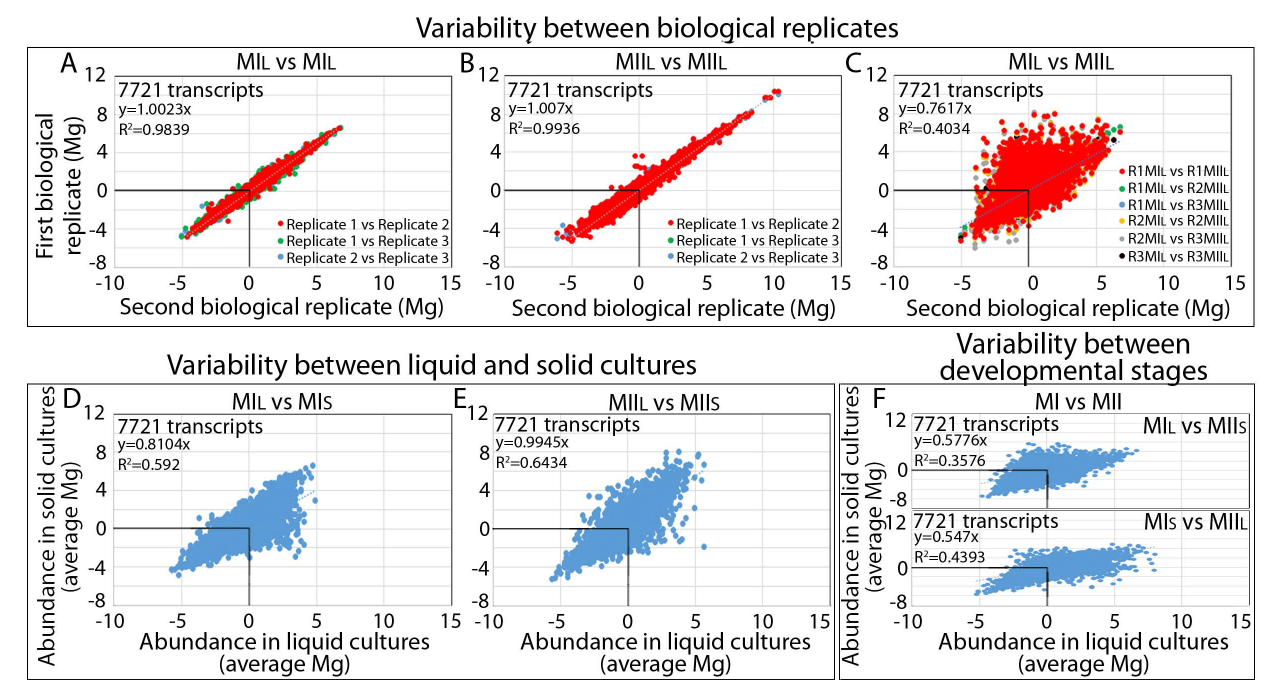
Figure 2. Quantitative transcriptomic data analysis . Correlation of transcription abundance values (log2 ratio against chromosomal DNA). Upper panels - biological replicates: (A) MIL vs. MIL, (B) MIIL vs. MIIL, (C) MIL vs. MIIL (three biological replicates compared in pairs). Lower panels - developmental stages (average abundance values from three biological replicates: (D) MIL vs. MIS, (E) MIIL vs. MIIS, (F) MIL vs. MIIS and MIS vs. MIIL.